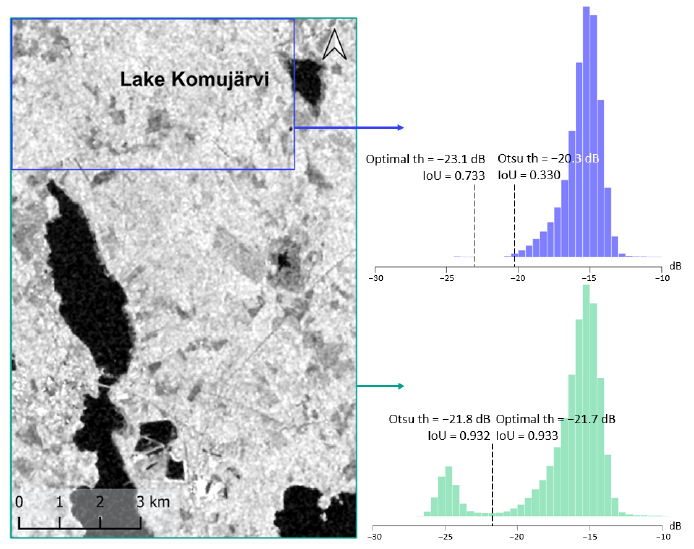
Figure 17. Fragment of the study area— σ 0 data with Lee Sigma 7 × 7 speckle filtering based on the VH MNDWI reference mask and σ 0 histogram of the study area (green) and a small fragment VH